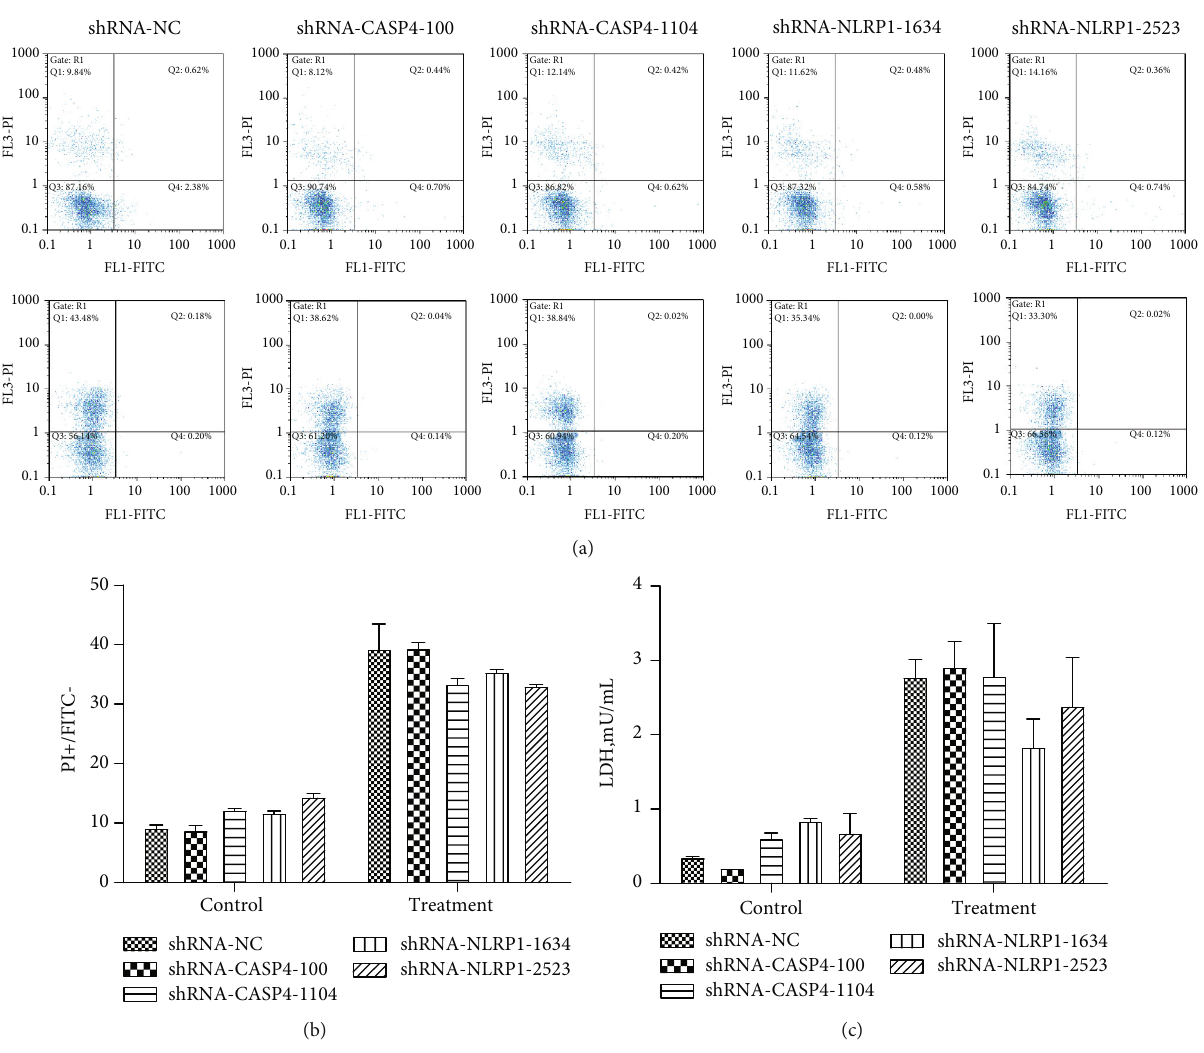
Figure 4: Detection of dead cells. (a) Flow cytometry results of Annexin V-FITC/PI staining. (b) Quantitative analysis for the Annexin V- FITC/PI results. (c) The concentration of LDH. Control: cells were collected after transfection with shRNA vector for 72 h. Treatment: cells were collected after transfected with shRNA vector for 72h and treated with hUCMSC-CM for 24 h. Data were presented as mean ± SD of three independent